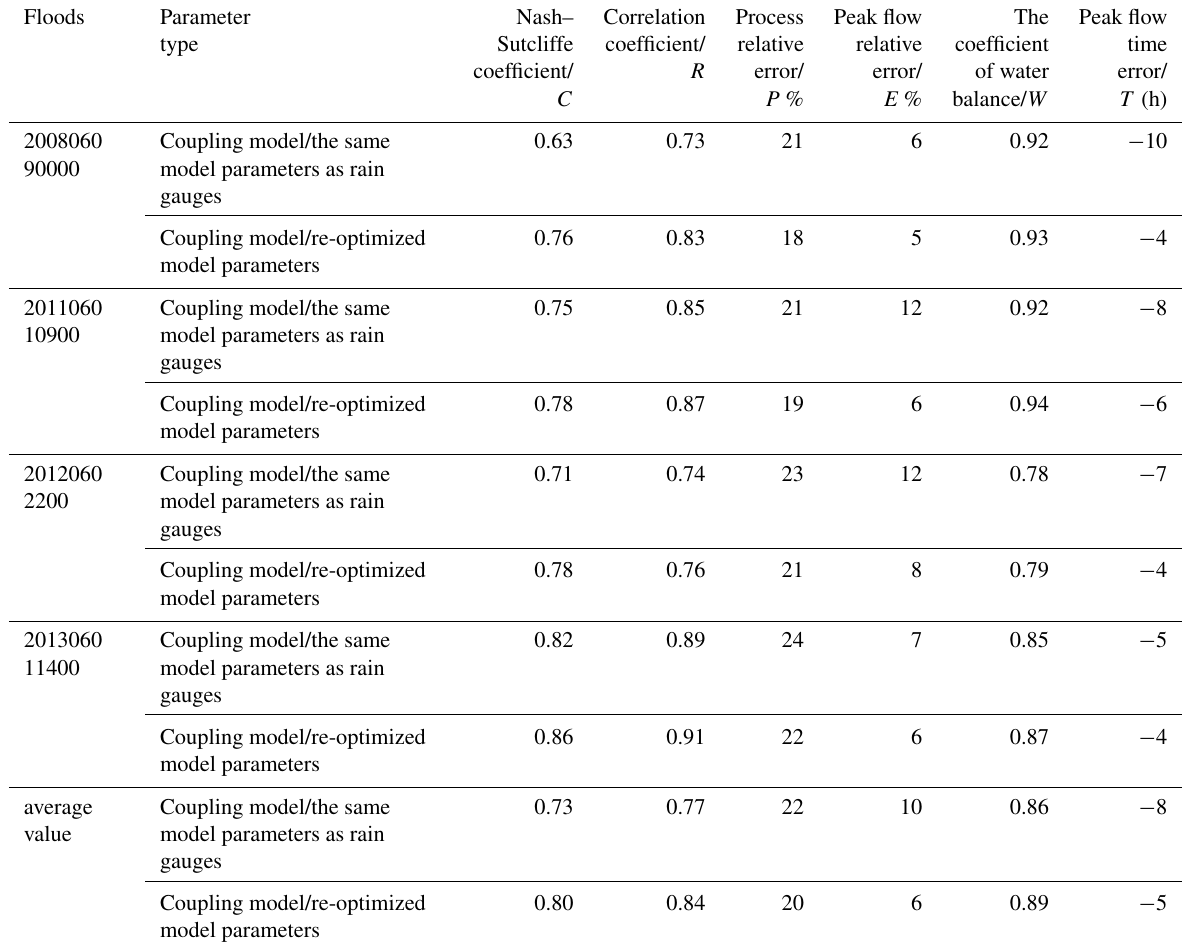
Table 8. The effect of recalibrating the coupling model parameters. Floods Parameter Nash– Correlation Process Peak flow The Peak flow type Sutcliffe coefficient/ relative relative coefficient time coefficient/ R error/ error/ of water error/ C P % E % balance/